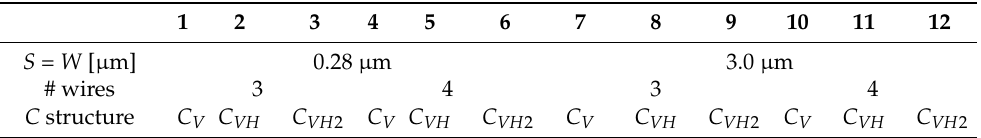
Table 2. Fabricated test structures for scalable